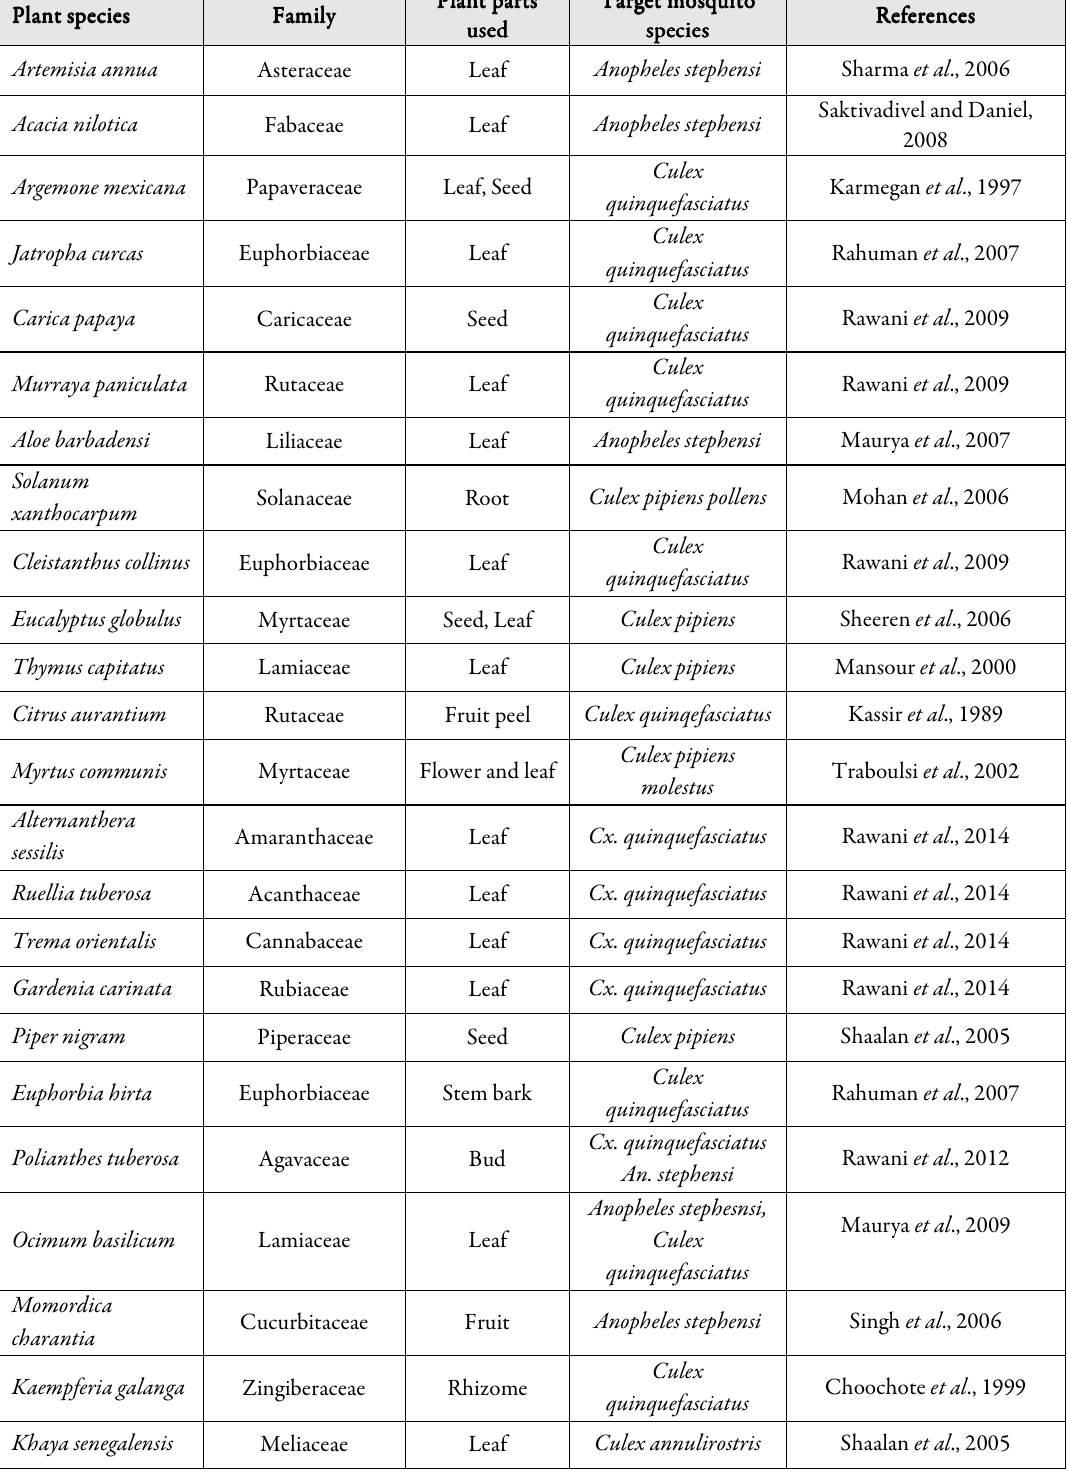
Table 8. List of plants and plant parts reported so far as mosquitocidal agent Plant